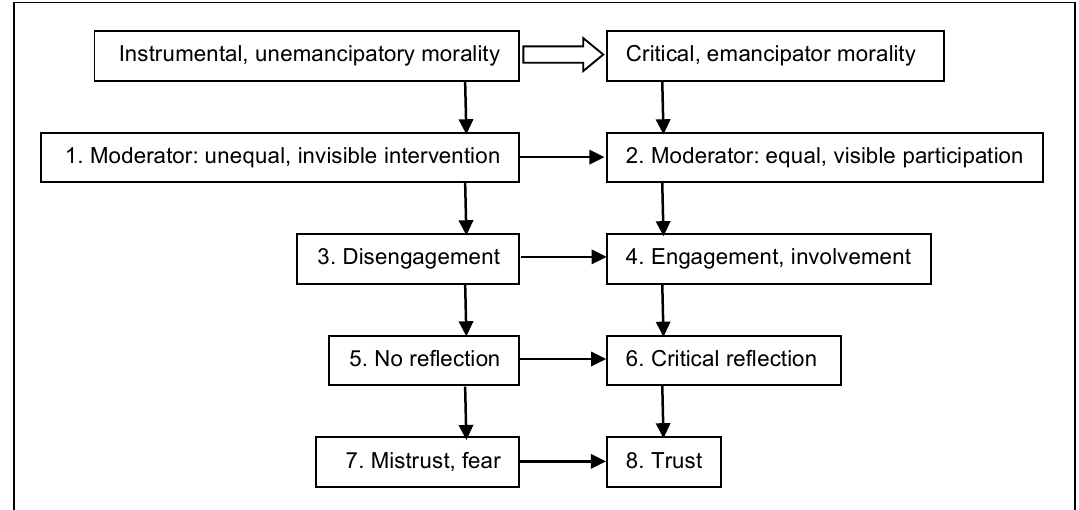
Figure 2 The influence of the moderator on participant